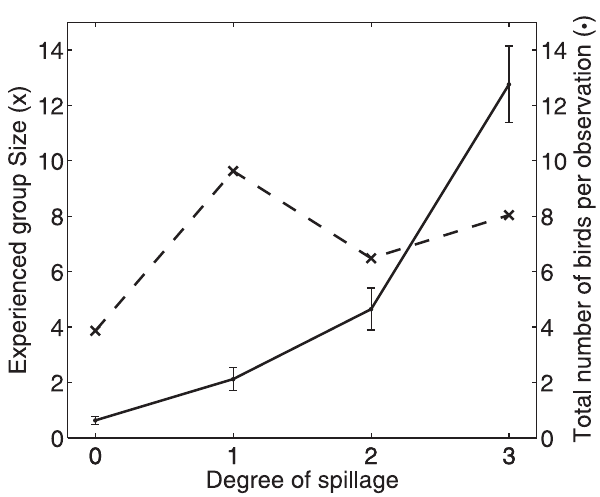
Figure 5. Effect of food spillage. The average group size N experienced by an individual (x) and the average total number of birds ) for different food spillage levels. For the average per observation ( total number of birds per observation, we took the mean of each 15- minute observation interval and averaged all the means in the same food spillage level. The error bar shows the standard error of the